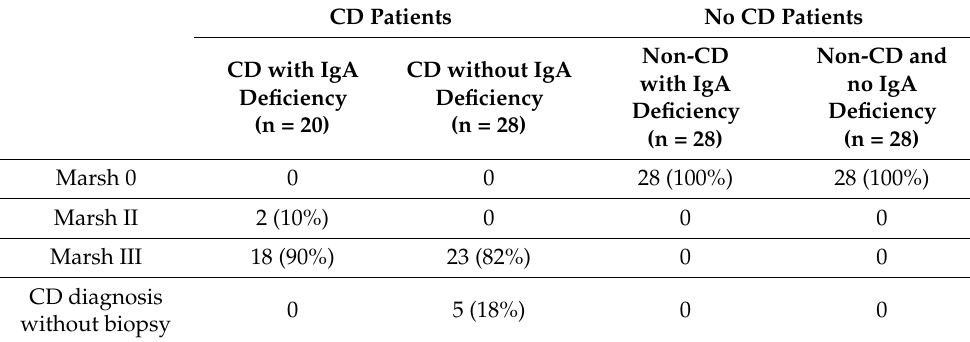
Table 2. The histological changes of intestinal biopsies